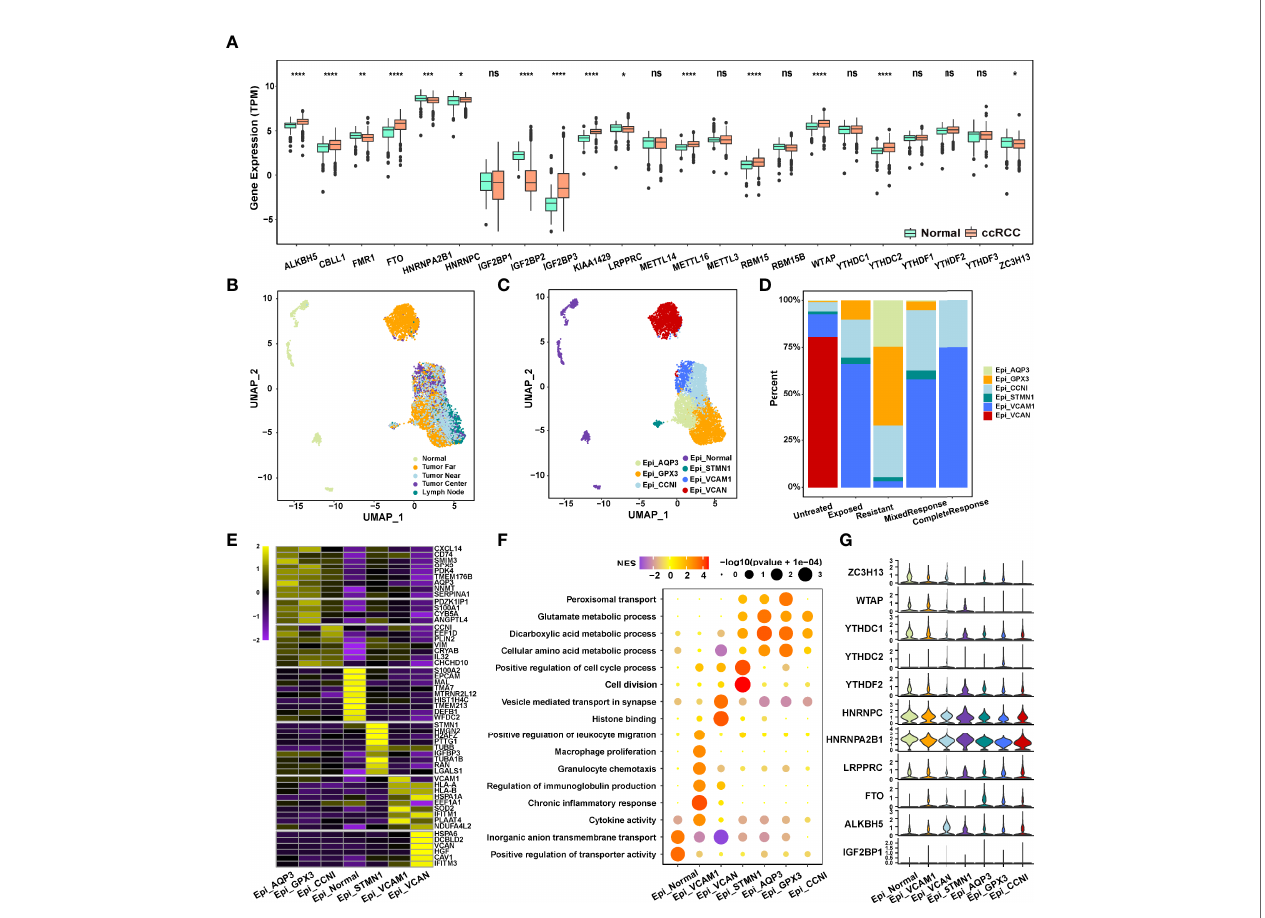
FIGURE 1 | (A) Expression of 23 m 6 A RNA methylation regulators between renal cancer and normal tissues in the TCGA-ccRCC cohort. (B, C) The UMAP plot and overview of epithelial cells by the origin and cell type of the cells. (D) Composition of various epithelial cells in different immunotherapeutic responses. (E) The heatmap of marker gene expression in 7 identi fi ed epithelial cell subsets. (F) Dot plot analysis of KEGG pathway enrichment of 7 epithelial cell subsets. (G) Violin plots showing the partial expression of m 6 A regulators for each epithelial cell type ("*p < 0.05; **p < 0.01; ***p < 0.001; ****p < 0.0001; ns, not signi fi